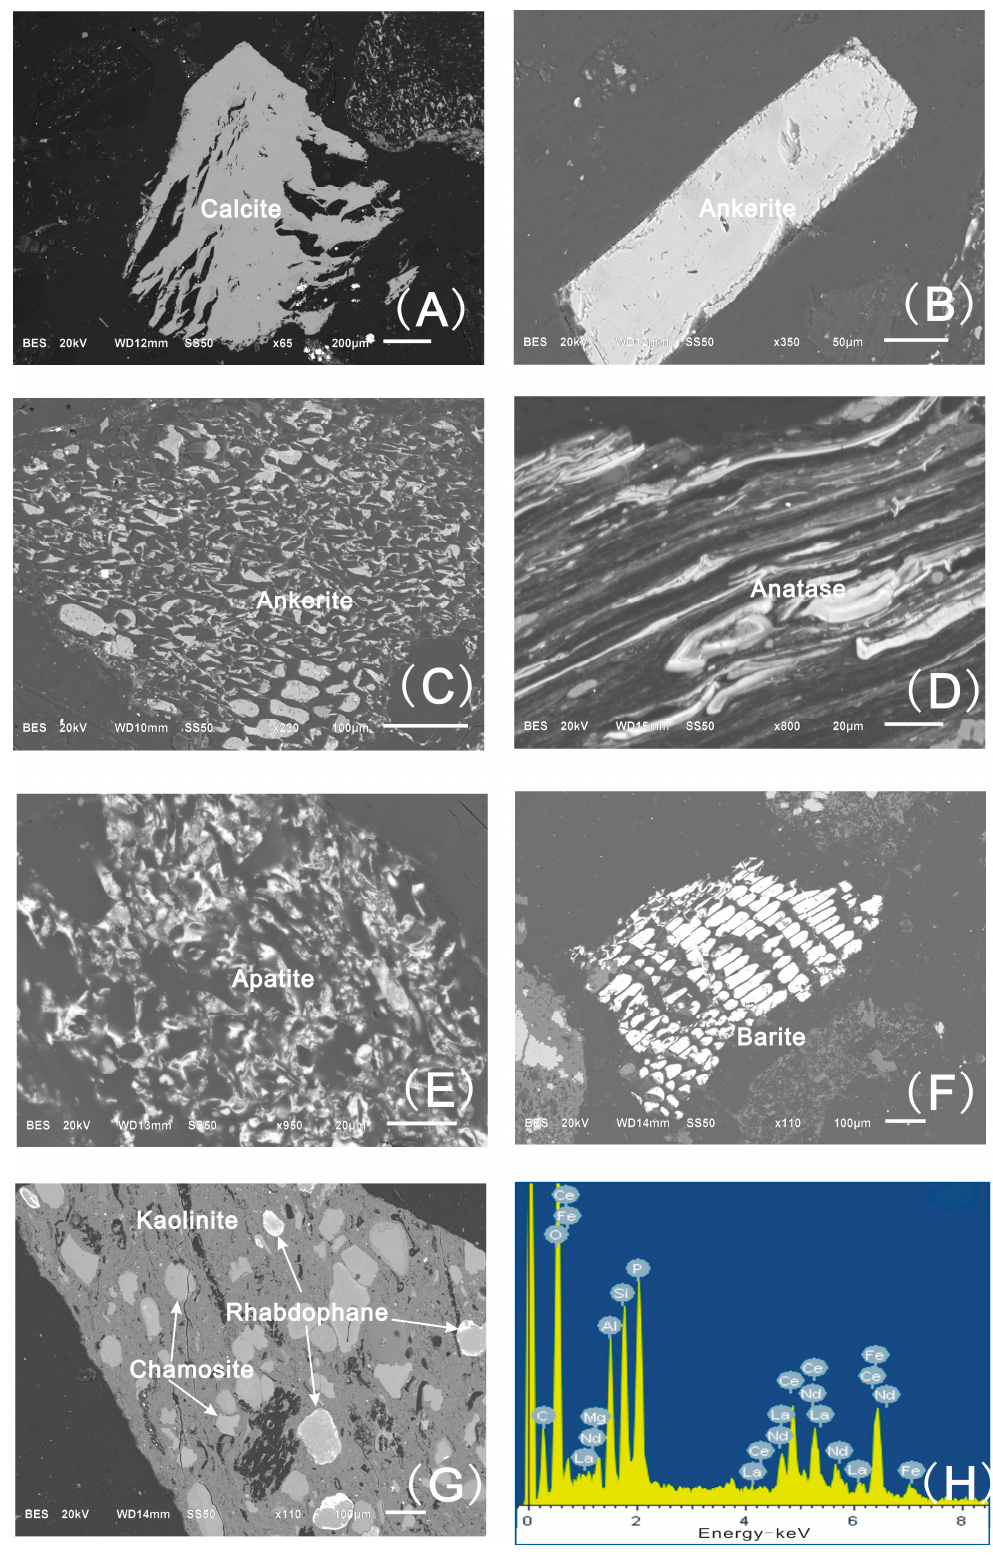
Figure 5. SEM back scattering images of minerals in the Zhongliangshan coals. ( A ) fracture-filling calcite in sample K1-1; ( B ) cell-filling ankerite in sample K1-1; ( C ) cell-filling ankerite in sample K10-4; ( D ) anatase occurring as replacement of glass shards or pumice in sample K4-2; ( E ) apatite distributed in the collodetrinte in sample K10-3; ( F ) barite occurring as cavitiy-fillings in sample K7-1; ( G ) rhabdophane, kaolinite and chamosite in sample K7-1; ( H ) the energy dispersive X-ray (EDX) spectrum of rhabdophane in sample K7-1.